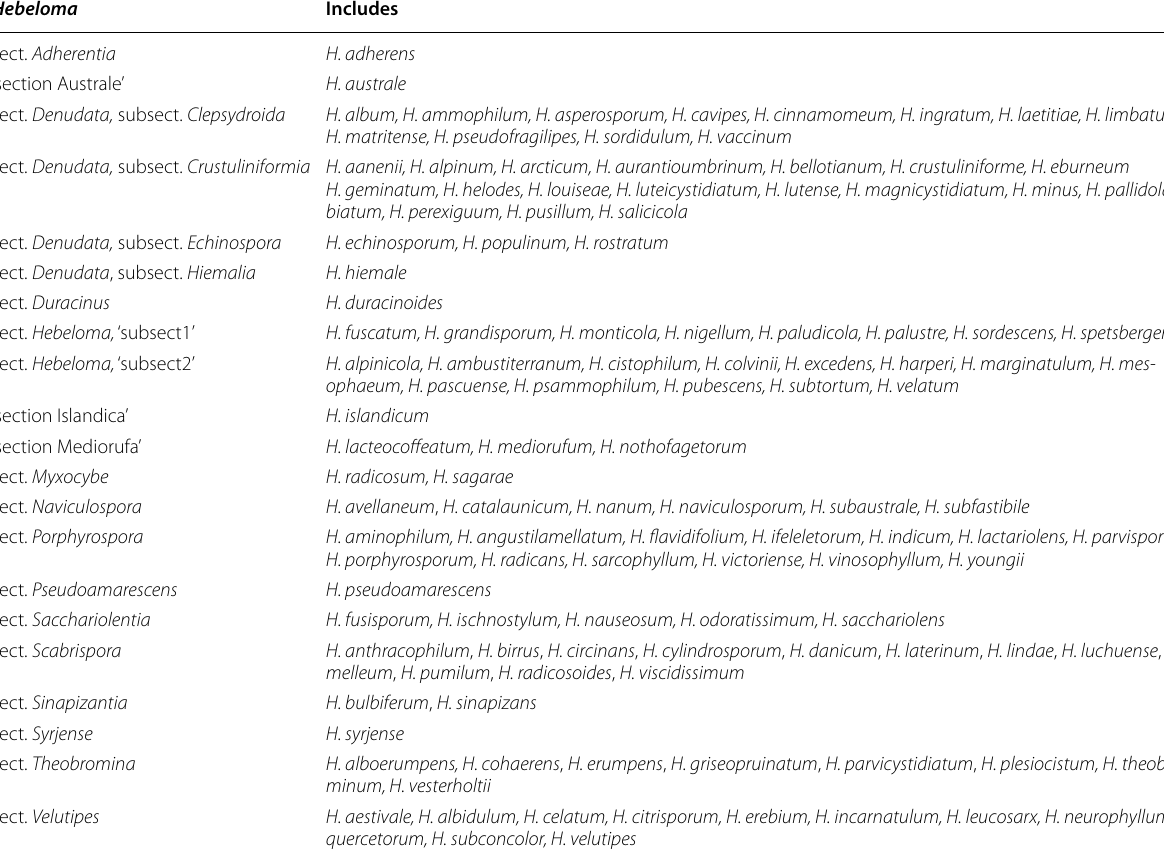
Table 1 Current names of analysed and accepted Hebeloma species, by section Hebeloma